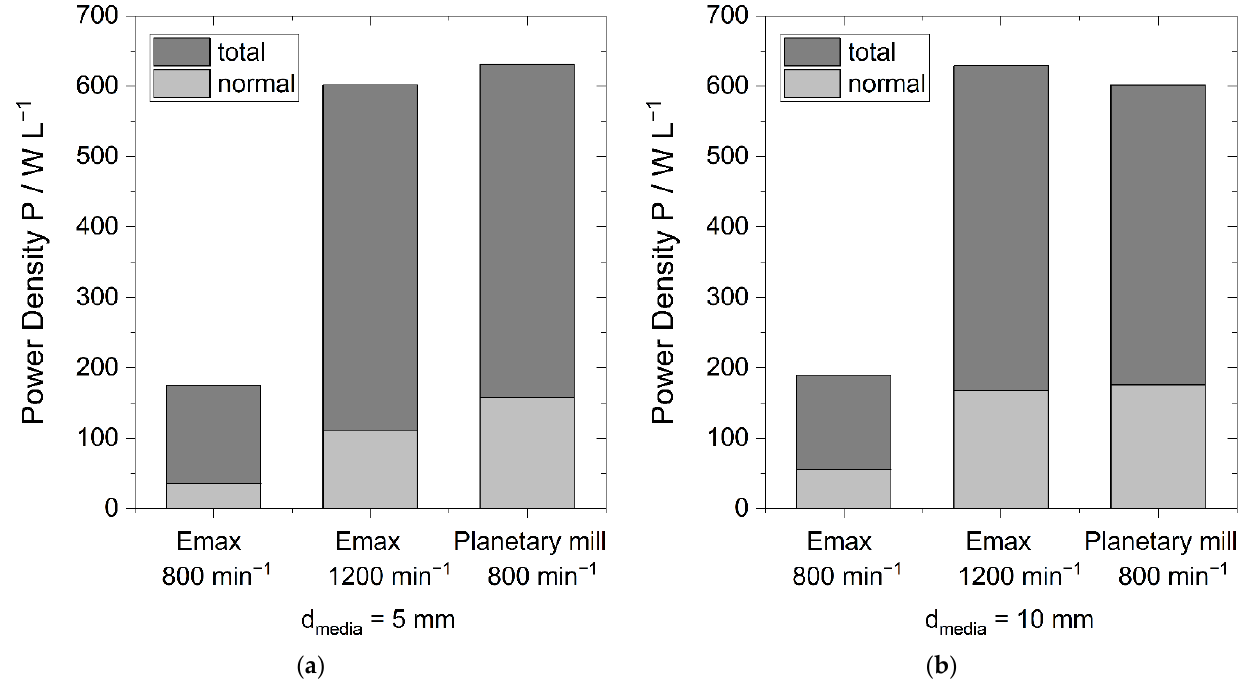
Figure 10. Comparison of power densities for Emax (n = 800 min − 1 and n = 1200 min − 1 ) and planetary ball mill (n = 800 min − 1 ), ϕ media = 0.3: ( a ) media size 5 mm; ( b ) media size 10